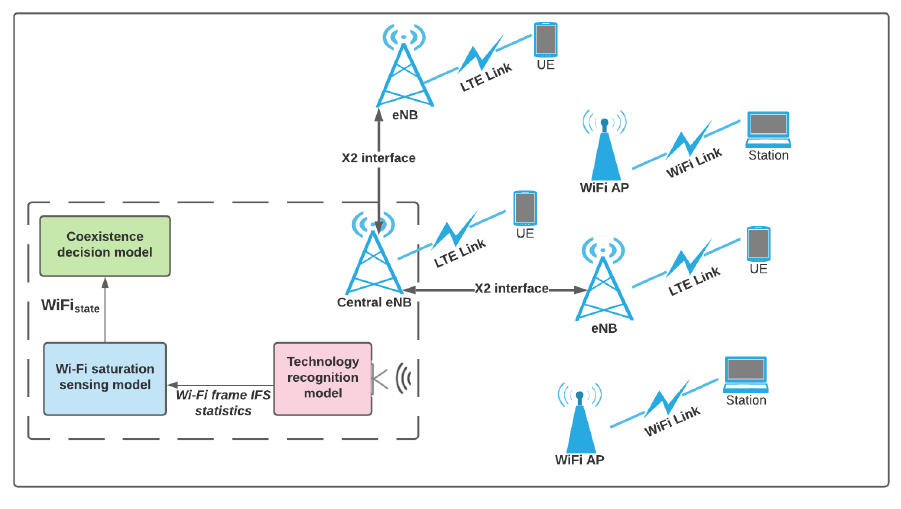
Figure 1. Topology of proposed Coexistence scheme for uncoordinated LTE-U and WiFi